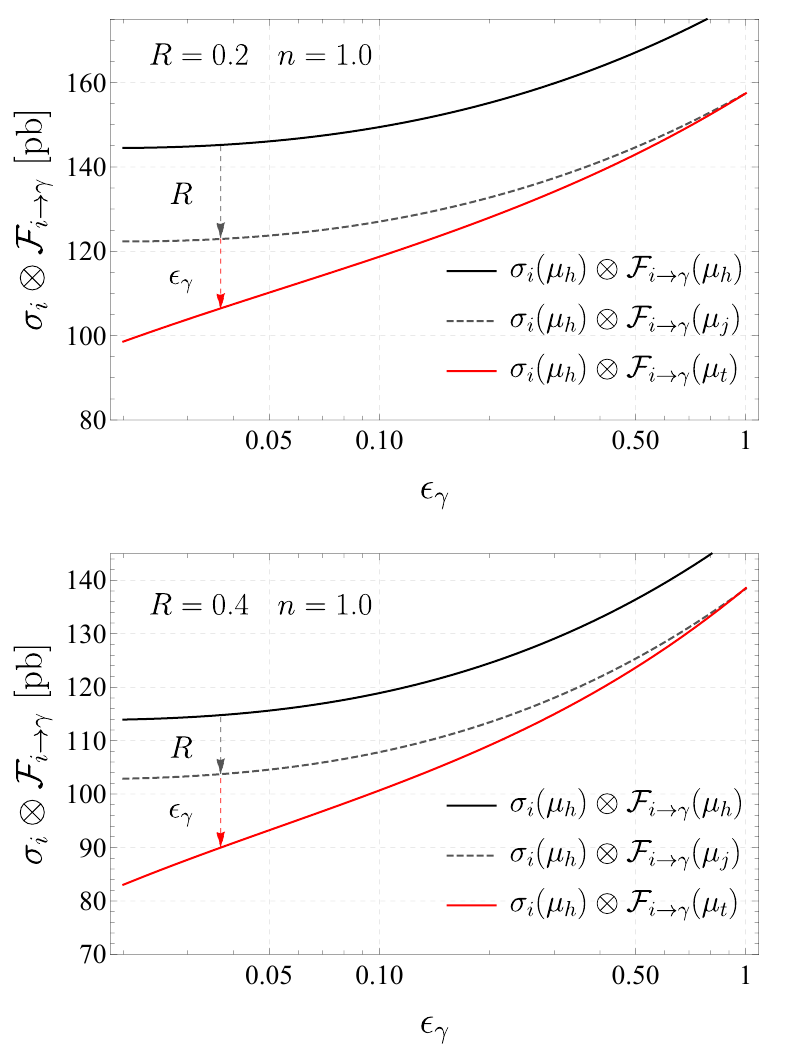
Figure 12 . Effect of the resummation of ln( R ) and ln( (cid:15) γ ) terms for R = 0 . 2 (upper plot) and R = 0 . 4 (lower plot). The solid black curve shows the result without resummation, the dashed curve includes the resummation of ln( R ) terms. The red curve resums both types of logarithms. Only the fragmentation contribution is shown, to obtain the full cross section the direct photon production contribution with σ dir ≈ 290 pb has to be added. (The direct cross section is somewhat lower than the one given in section 3 because we use dynamic scales rather than fixed ones, see table